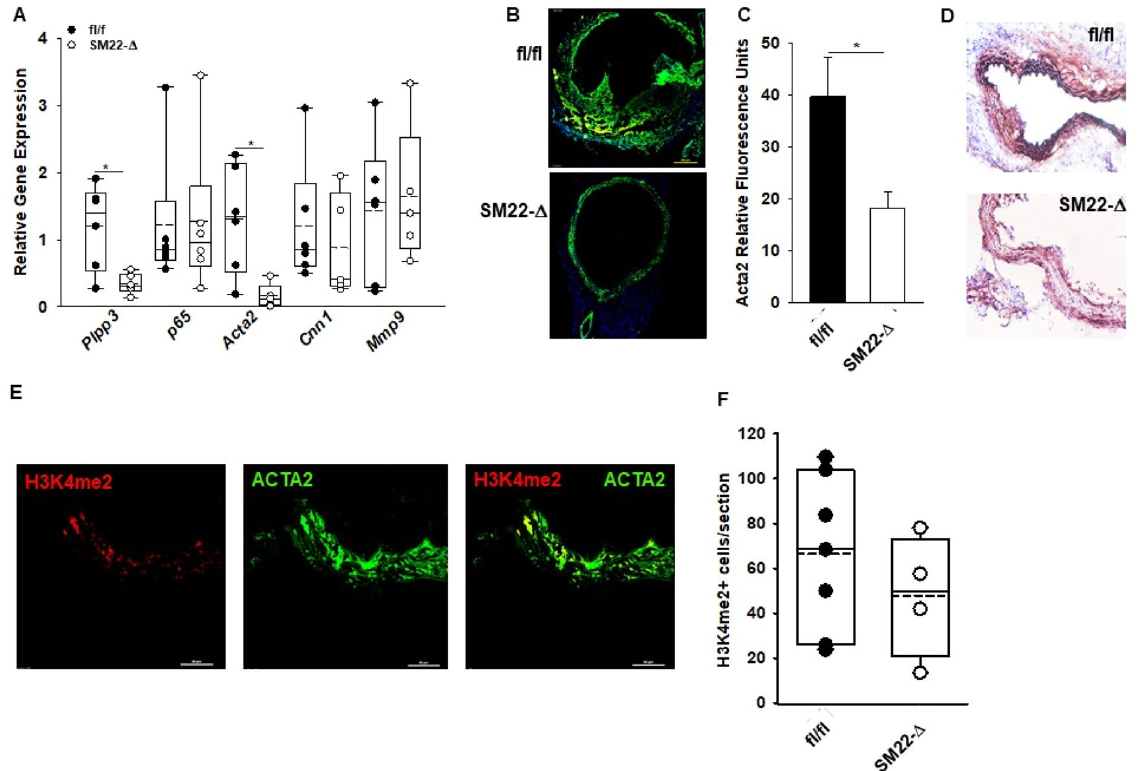
Figure 4. Smooth muscle cell phenotypic switching in SM22-Δ mice. ( A ) Abdominal aorta gene expression from fl/fl (n = 5) and Sm22-Δ (n = 5) mice following 4 week AngII treatment. Data is represented as relative gene expression. Relative gene expression was calculated using an average CT value from fl/fl mice treated with AngII for 4 weeks. fl/fl mice treated with AngII for 4 weeks were used as the control and compared to SM22-Δ mice treated with AngII for 4 weeks. * P < 0.05, unpaired two- tailed student t-test. ( B ) Immunofluorescence of Acta2 (green) and DAPI (blue) in abdominal aorta from fl/fl and SM22-Δ mice following 28 day AngII treatment. ( C ) Relative Acta2 fluorescence in abdominal aorta from fl/fl (n = 7) and SM22-Δ (n = 4) mice treated with AngII. Acta2 staining was quantified with Image J and presented as mean ± SEM. * P < 0.05, Welch’s t-test. ( D ) Representative calponin stained images of abdominal aorta from fl/fl and SM22-Δ mice following 4 weeks AngII treatment. ( E ) Immunofluorescence of H3K4me2 (red) on Myh11 promoter and Acta2 (green) in abdominal aorta from fl/fl mice following 28 day AngII treatment. Representative image is shown. ( F ) Number of H3K4me2+ cells per section from fl/fl (n = 7) and SM22-Δ (n = 4) mice following AngII upregulation of Oct4 mRNA in abdominal aorta of control SM22-Δ mice (Fig. 5F) and isolated aortic SMC from SM22-Δ mice (Fig. 5G). These findings suggest that in the absence of LPP3, SMC have lower expression of SMC